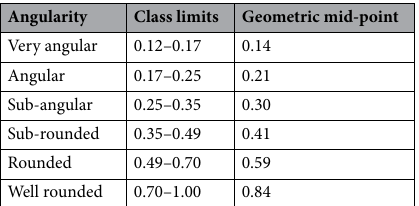
Table 1. Classification of the soil particles based on their angularity 26 .